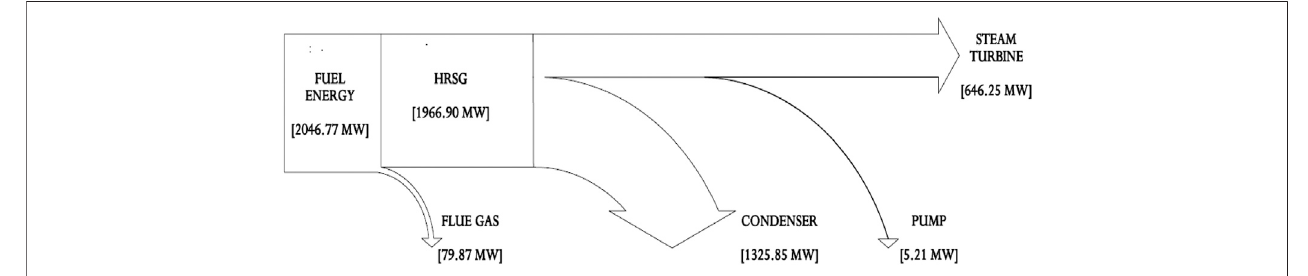
FIGURE 6 | Sankey diagram of energy balance showing fl ow rates of